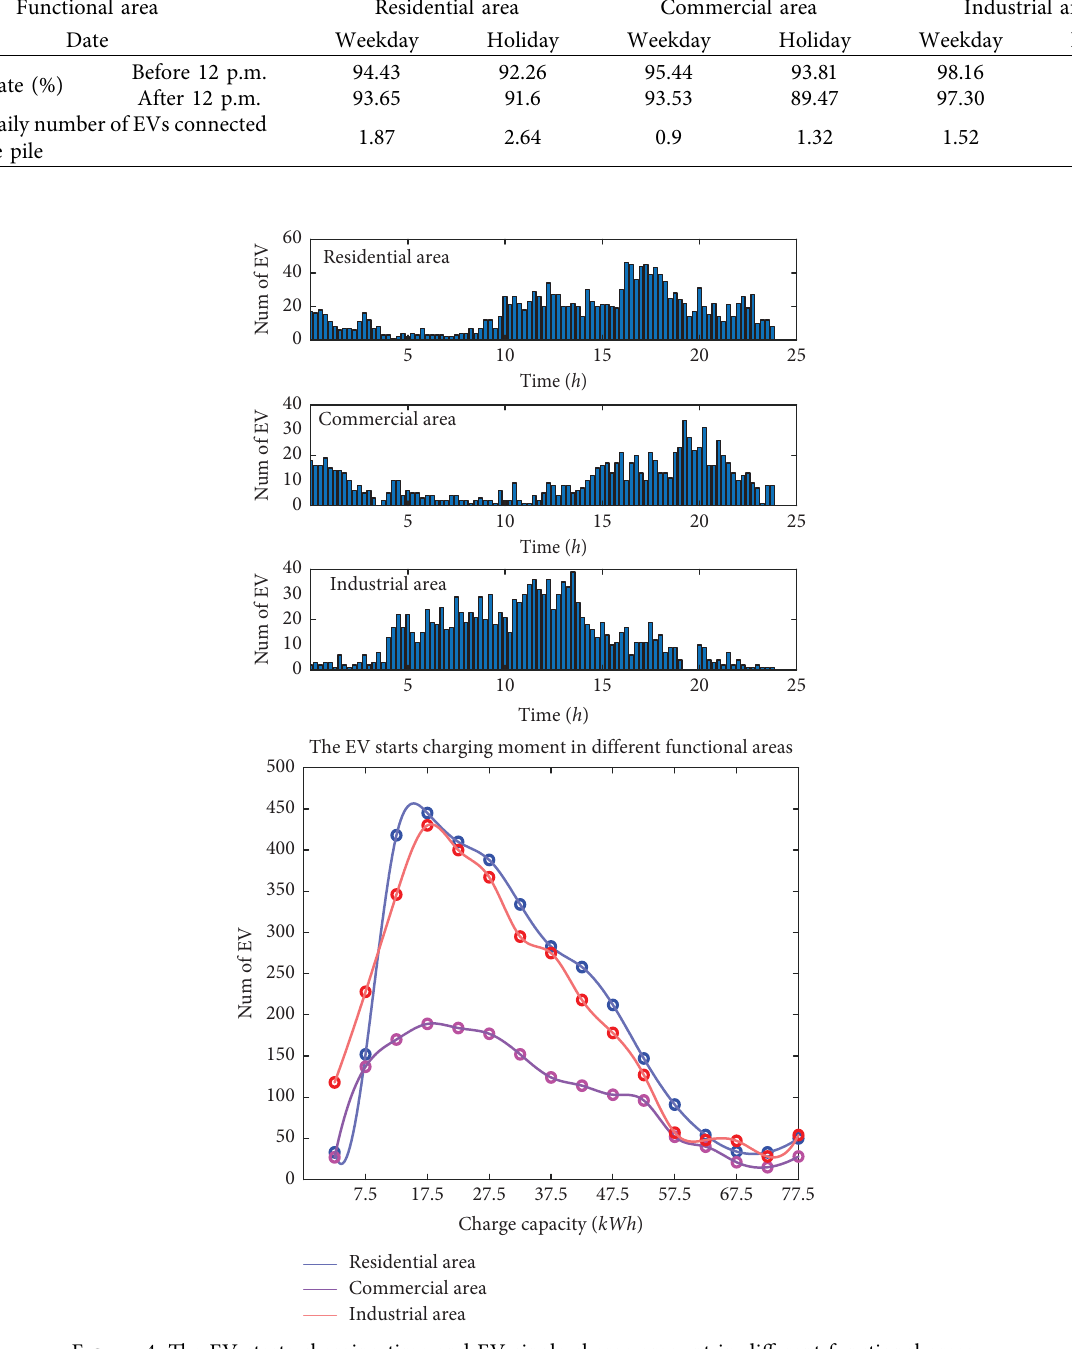
Figure 4: Te EV starts charging time and EV single charge amount in diferent functional